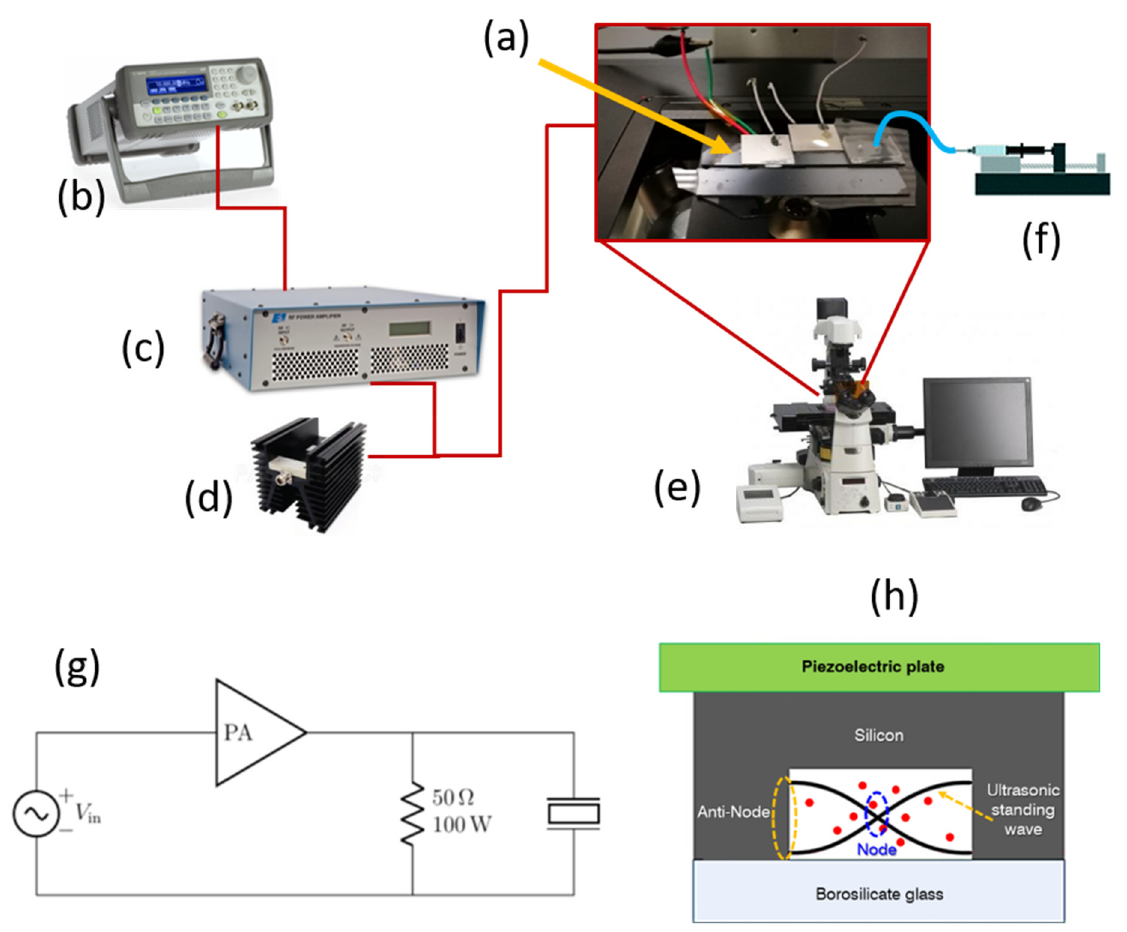
Figure 2. Experimental setup: ( a ) BAW device and resonating plate in which: the light blue line indicates the MP solution and the red one the electrical connections to actuate the piezoelectric elements (white), ( b ) waveform generator, ( c ) RF power amplifier, ( d ) dummy load, ( e ) optical fluorescence microscope, ( f ) syringe pump, ( g ) electrical diagram of the experimental setup used to generate the US standing wave into the microfluidic channel, ( h ) cross section sketch of the BAW device operating principle.